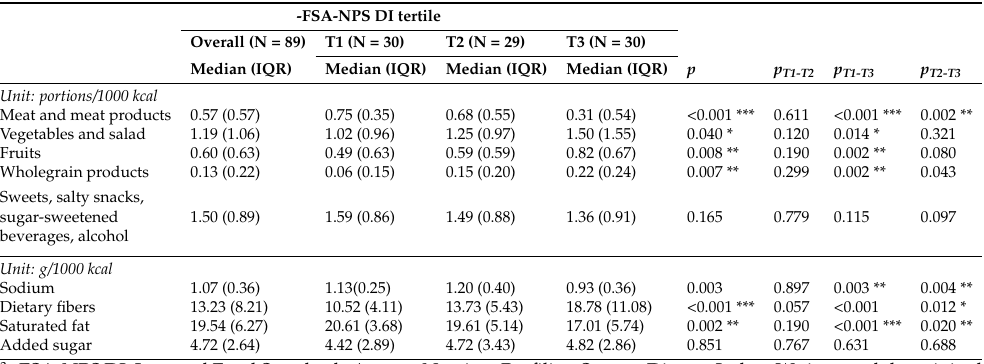
p T1-T2 p T1-T3 p T2-T3